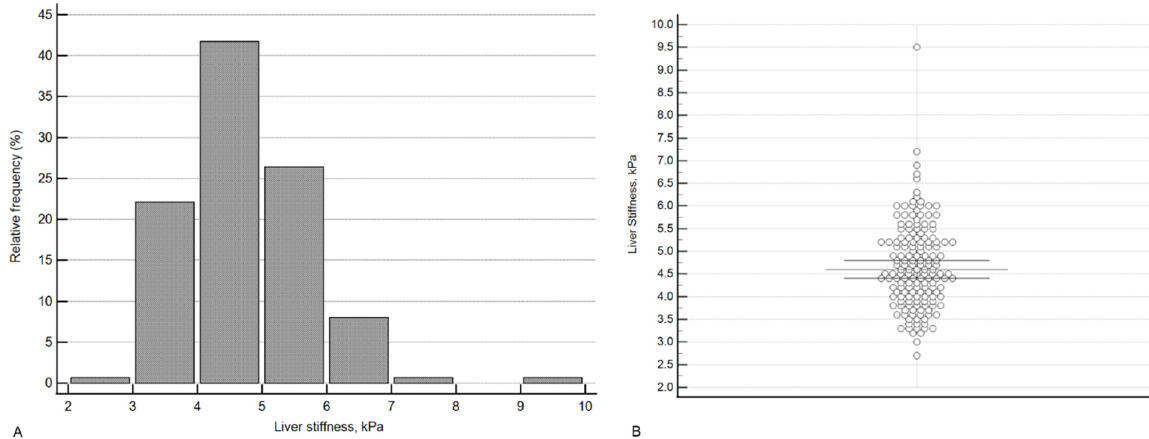
Figure 1. Distribution of liver stiffness values in relative ( A ) and absolute ( B ) values. In Figure 1B, each point represents a single case. The lines indicate the median and the 95% confidence interval for the median.